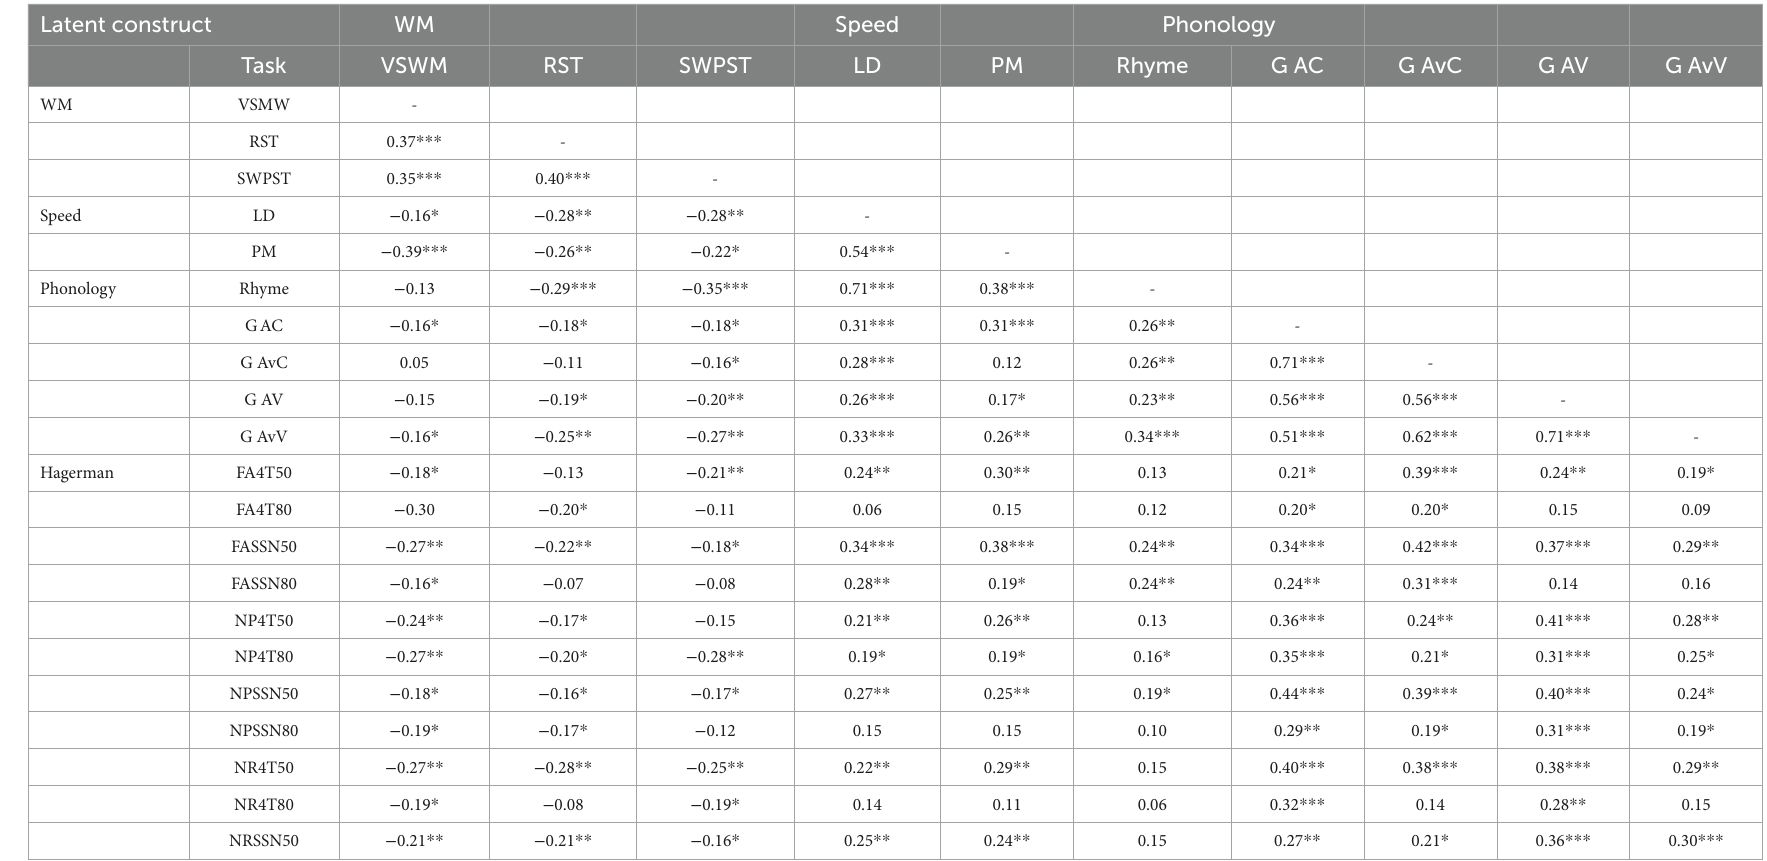
TABLE 3 Cross-task correlations across tasks for each latent construct. Latent